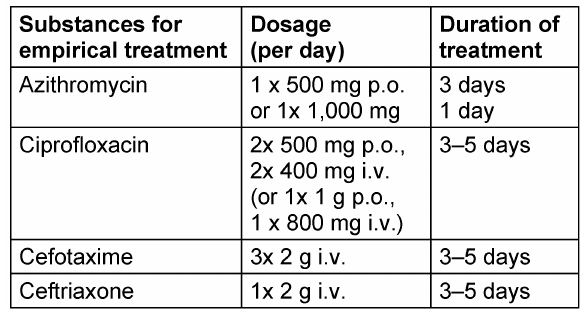
Table 3: Recommendation for calculated treatment of